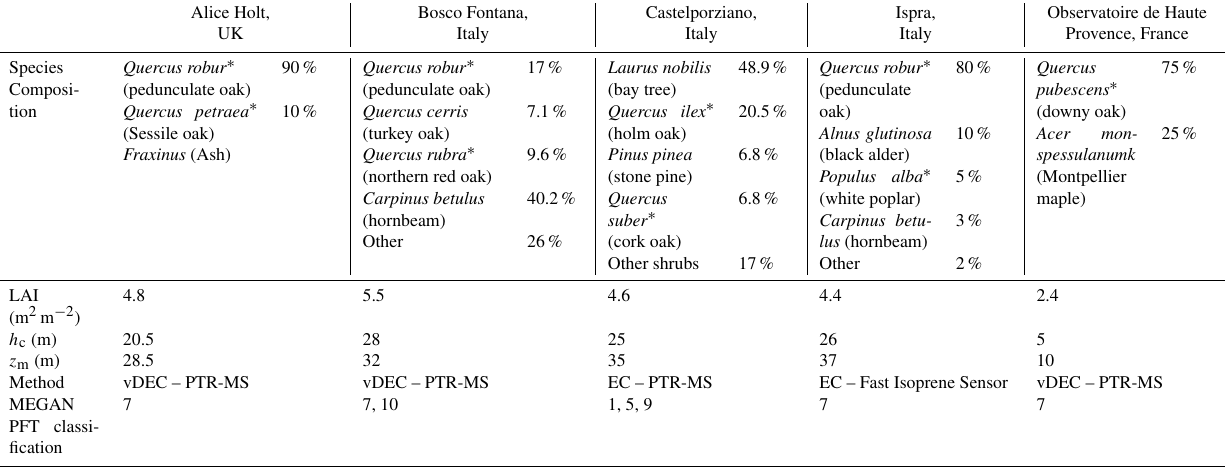
Table 1. Detailed breakdown of species composition and measurement approach for each of the five sites used in this study. Alice